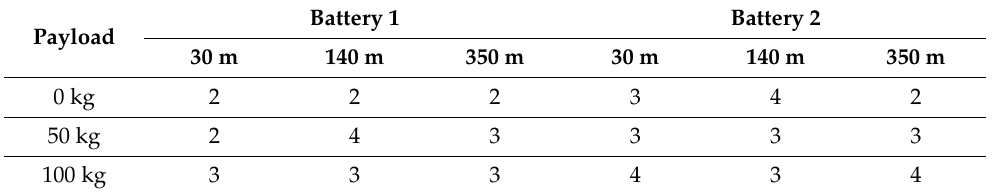
Table 2. Number of full battery discharge cycles for different mission lengths and payloads.